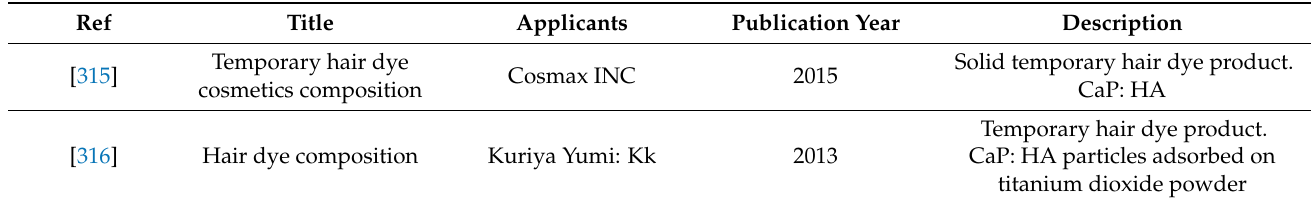
Table 6. List of patents about calcium phosphates in hair